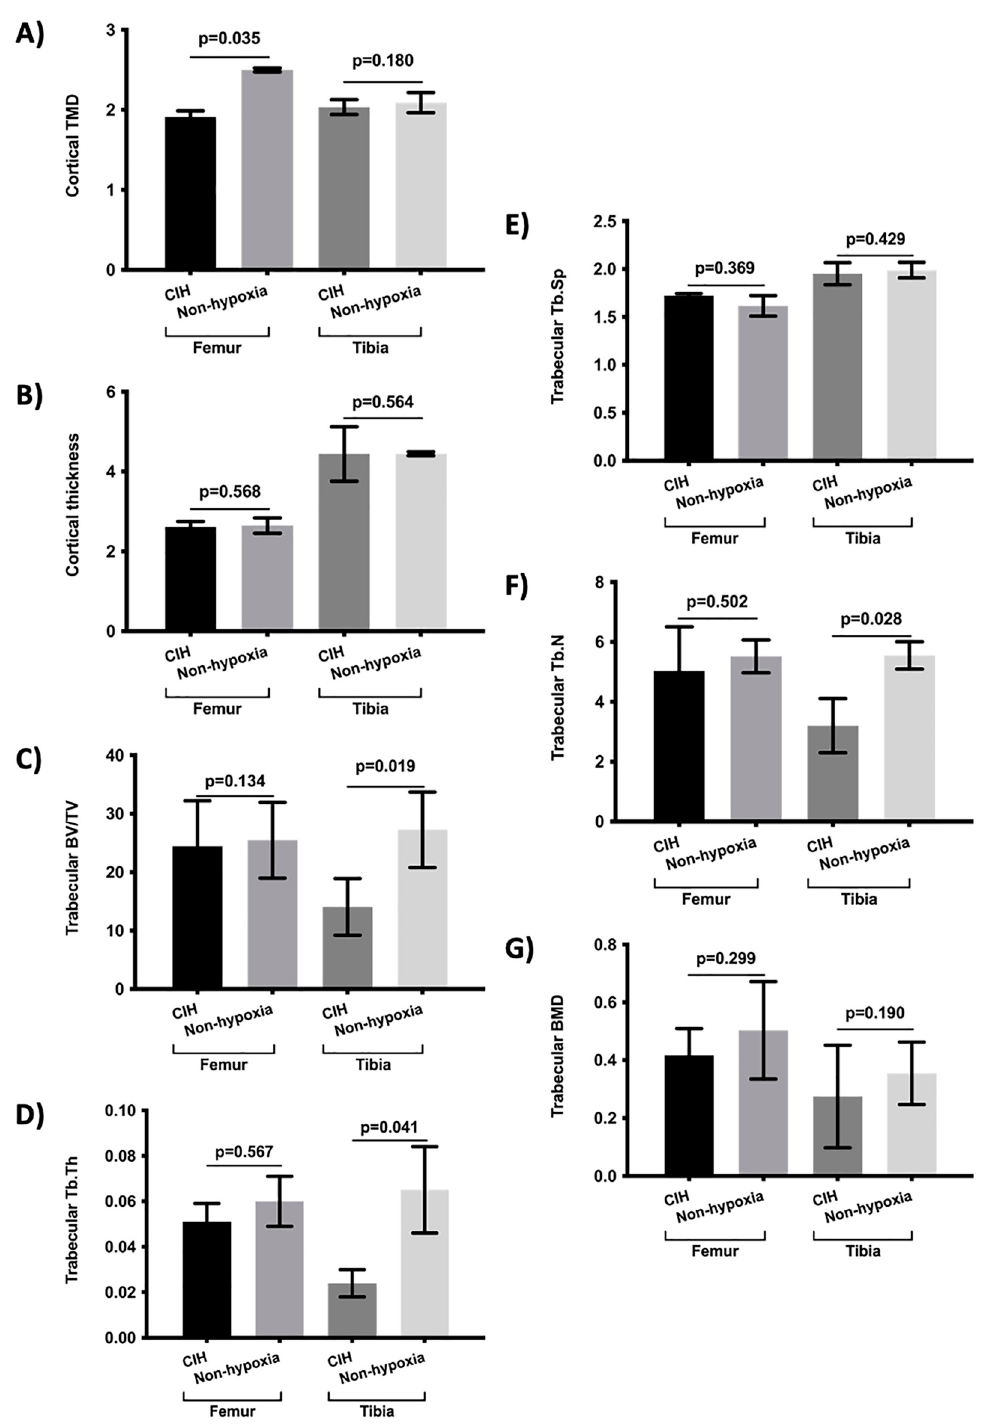
Figure 2. Comparison of bone morphometry parameters between rats subject to chronic intermittent hypoxic (CIH) condition and controls (non-hypoxia). ( A ) Cortical TMD, ( B ) cortical thickness, ( C ) trabecular BV/TV, ( D ) Tb.Th, ( E ) Tb.Sp, ( F ) Tb.N, and ( G ) Trabecular BMD. Variables are presented as mean (standard deviation). TMD: tissue mineral density, BV/TV: percent bone volume; Tb.Th: trabecular thickness; Tb.Sp: trabecular separation; Tb.N: trabecular number; and BMD: bone mineral density.